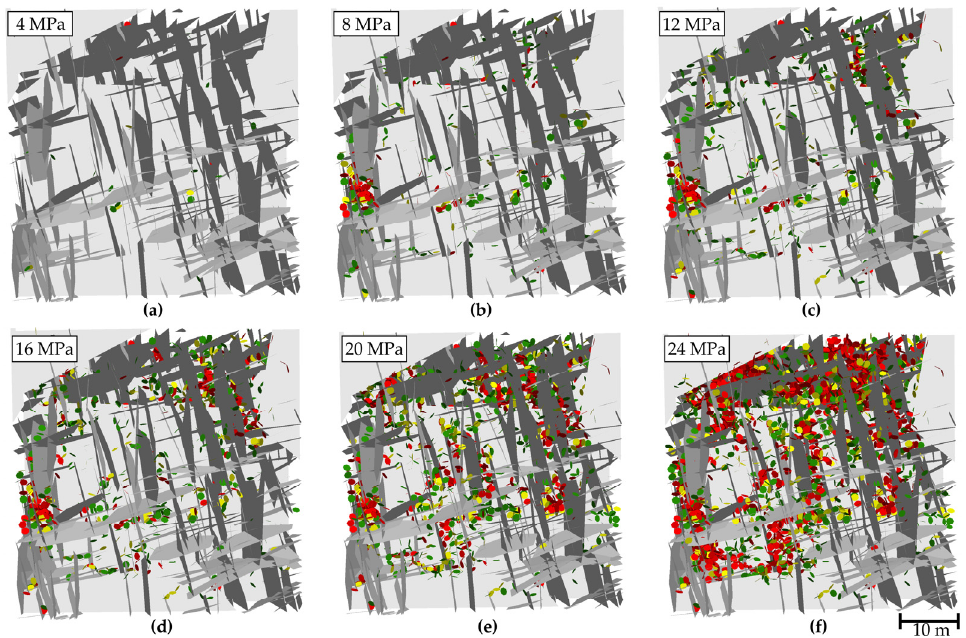
Figure 11. Exemplary sequence of the formation and coalescence of newly formed microcracks using the LS-SRM models with top view of the fractured rock mass. Predominant fractures, represented by the DFN model, are shown in gray shades. Newly formed microcracks are shown in green (33% broken), yellow (66% broken) and red (100% broken) using the flat joint model.